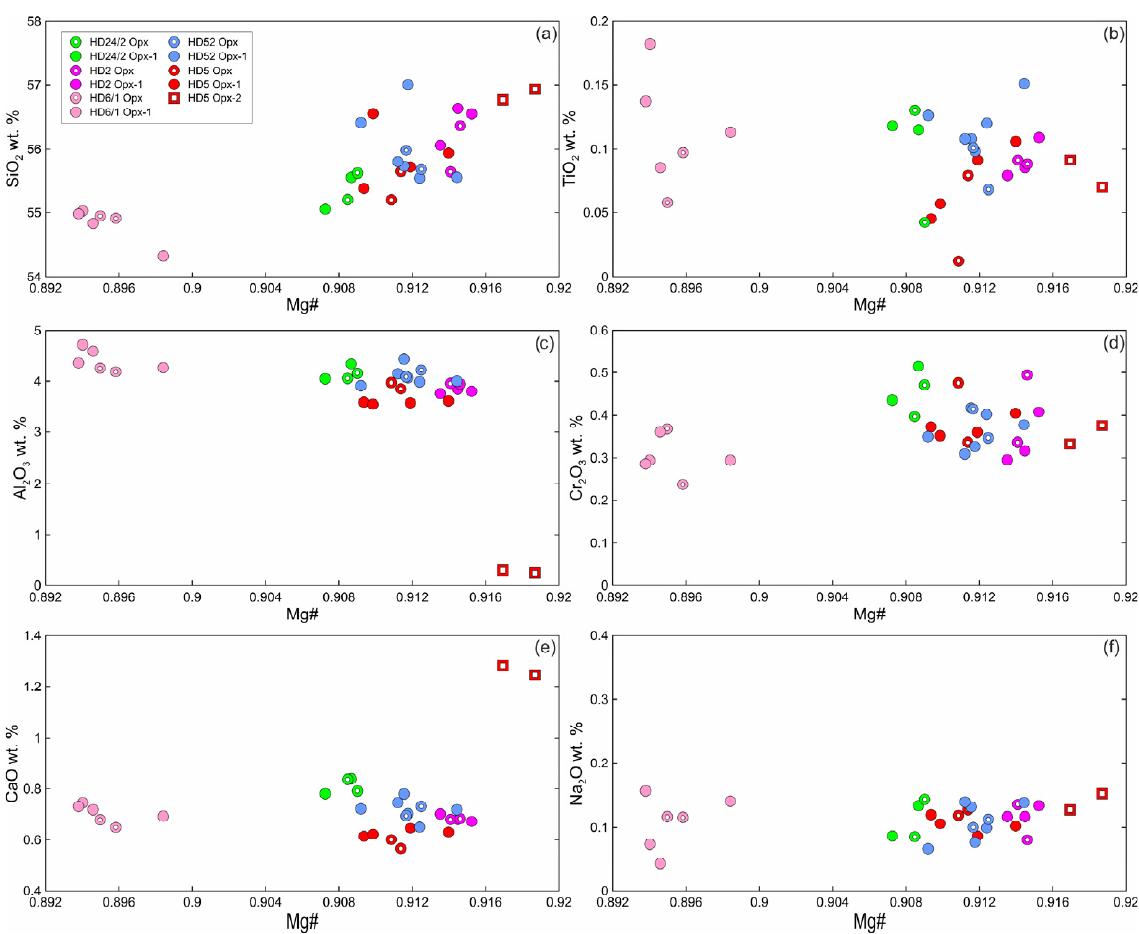
Figure 4. Composition of orthopyroxene from Tumusun lherzolite xenoliths. ( a ) SiO 2 ‐ Mg# (Mg# = Mg/(Mg + Fe 2+ )), ( b ) TiO 2 ‐ Mg#, ( c ) Al 2 O 3 ‐ Mg#, ( d ) Cr 2 O 3 ‐ Mg#, ( e ) CaO ‐ Mg#, ( f ) Na 2 O ‐ Mg#. Opx—primary Opx without reaction zones, Opx1—center of orthopyroxene with reaction zones, Opx2—secondary orthopyroxene from orthopyroxene reaction zones of the second type.